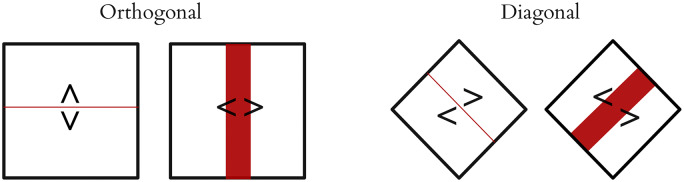
Diagonal split interfaces.Rotating the plane 45 degrees allows partition on both axes with only left-right decisions.